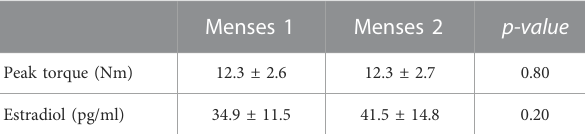
TABLE 1 Peak torque and estradiol concentrations collected in two sessions during